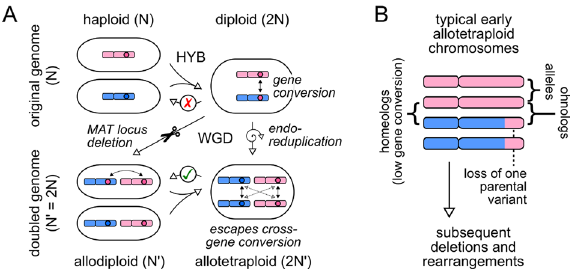
Figure 4. Homeologs and ohnologs in interspecies hybrids. ( A ) Routes to genome doubling in an interspecies hybrid. Pre-WGD hybrids are typically sterile (red cross) but WGD restores fertility (green tick). Allelic pairs in the pre-WGD cell become paralog pairs in the post-WGD cell. The WGD step can occur in one of two ways 41 : deletion of the MAT locus (diagonal arrow), which converts the pre-WGD diploid to a genome-doubled allodiploid (effectively a mating-competent haploid) 42,43 ; or endo-reduplication (vertical arrow), which converts the pre-WGD diploid to a genome-doubled allotetraploid (effectively a fertile diploid) 44 . In the allodiploid, gene conversion can lead to loss of one parental variant of a paralog pair. In the allotetraploid, gene conversion occurs predominantly between the WGD-derived alleles rather than the hybridization-derived paralogs. ( B ) Typical organization of allotetraploid chromosomes soon after WGD. This schematic is based on the genome of the lager brewing yeast S. pastorianus , a 500-y-old interspecies hybrid 45,46 . All genes are present as allelic pairs, most of which are completely homozygous due to gene conversion or introgression. Homeologs are paralog pairs in which one variant is inherited from each parent. Ohnologs are paralog pairs in which one parental variant has been replaced by the other, by meiotic recombination in a pre-WGD hybrid diploid or by subsequent gene